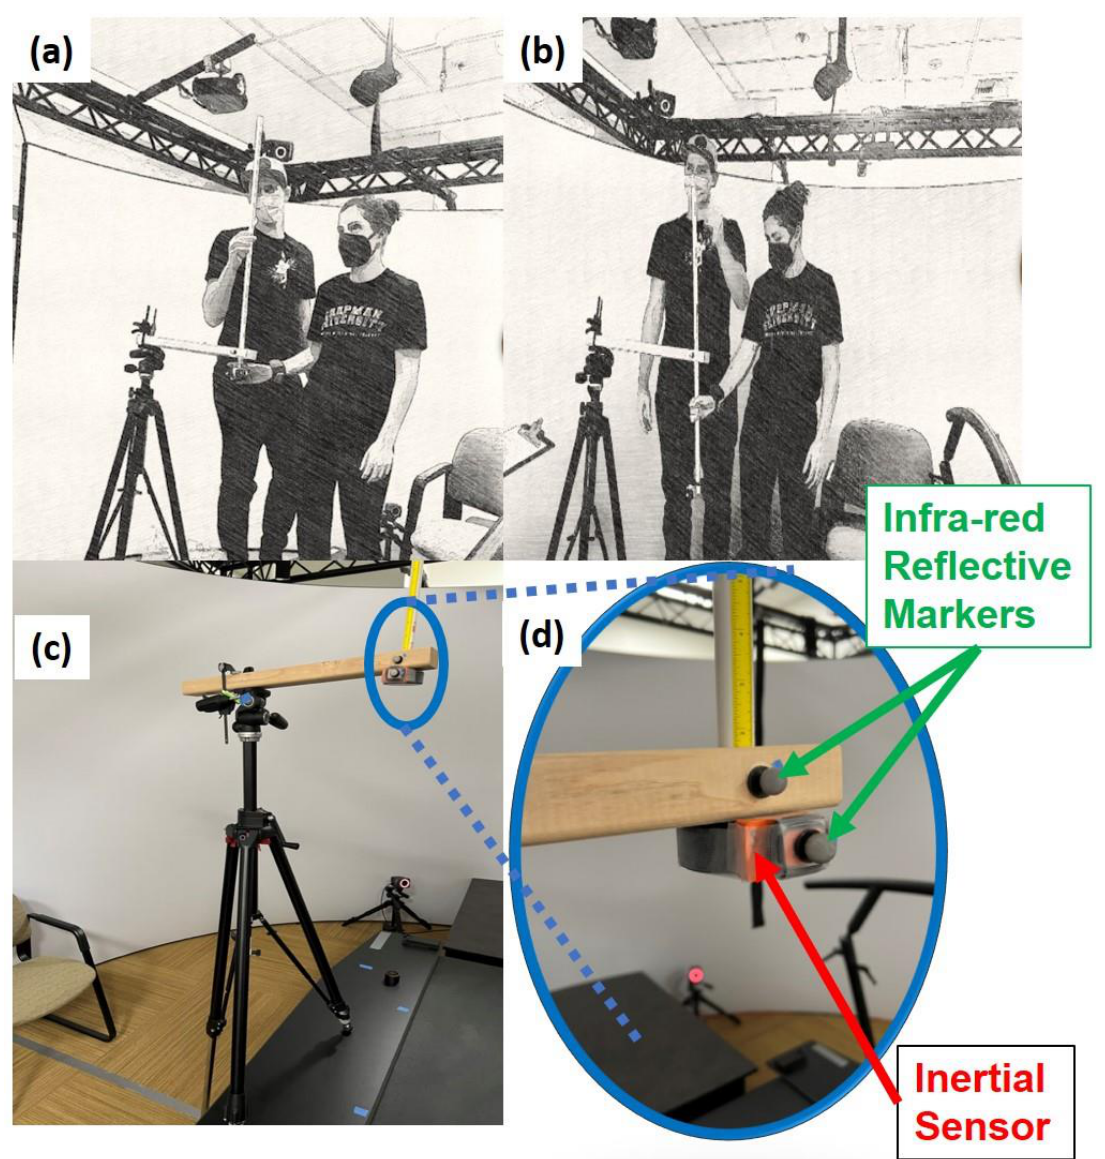
Figure 1. ( a ) Initial hand position before the drop, ( b ) a drop-stick catch, ( c ) the tripod-assisted initial position, ( d ) zoomed-out figure showing infrared markers and inertial